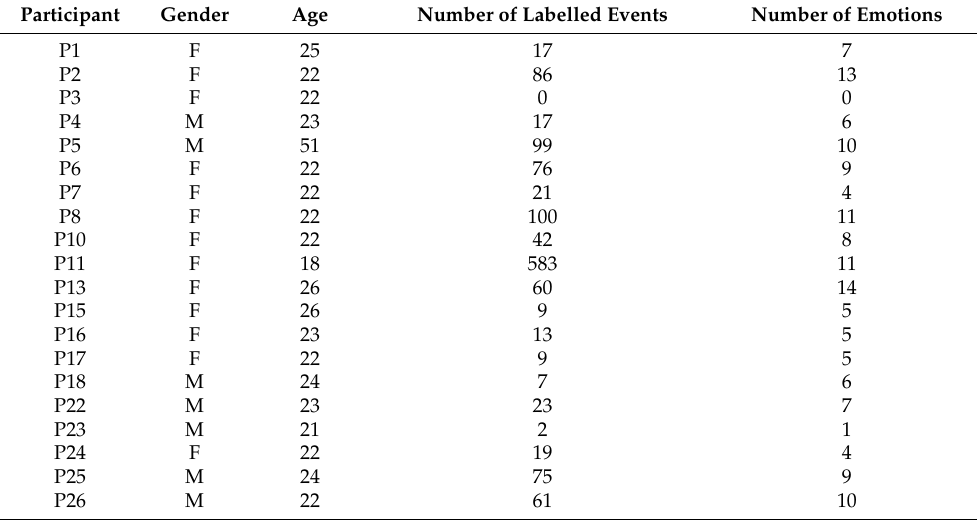
Table 1. Summary of the collected data. Twenty participants (P1–P26) took part in the experiment. For each participant, the gender and age are given in columns two and three, respectively. The number of labels added by each participant is given in the fourth column. The last column shows how many different emotions were labelled by each